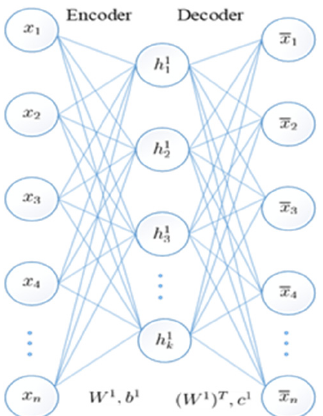
Figure 1. Basic structure of the autoencoder (AE).